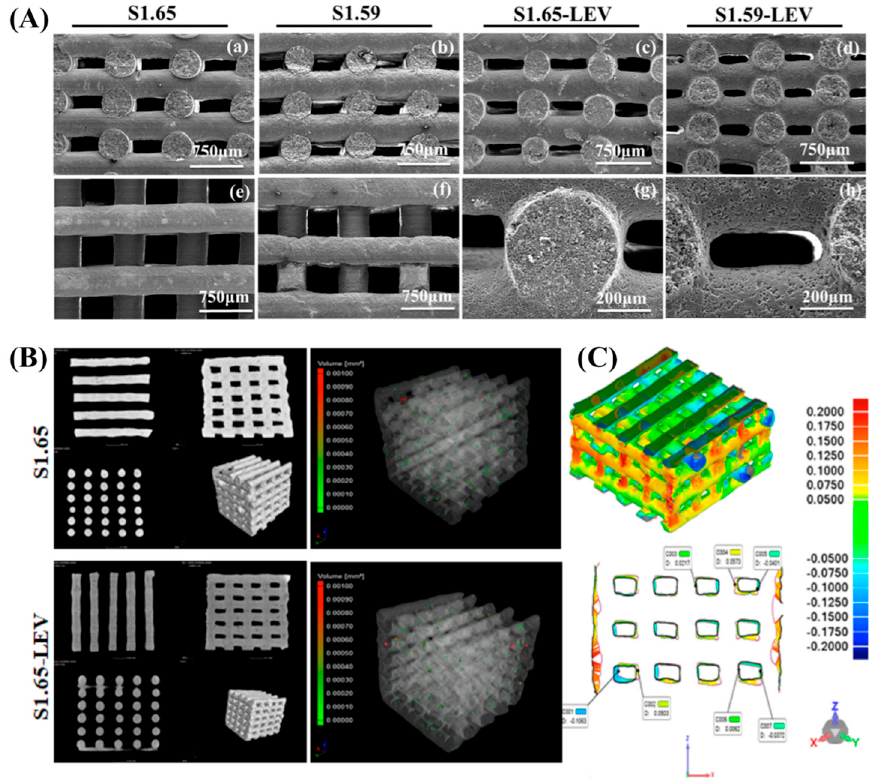
Figure 5. ( A ) Scanning electron micrographs showing morphological aspects of S1.65 (Ca/P = 1.65) and S1.59 (Ca/P = 1.59) scaffolds with and without levofloxacin: ( a – d ) lateral views; ( e , f ) top-views; ( g ) filament detail, ( h ) pore detail; ( B ) 2D (top plane and cross-section views) and 3D images of S1.65 scaffolds with and without drug (levofloxacin) obtained through Metrology CT and 3D reconstruction of the scaffolds mapped with color-coded for the internal porosity of filaments. ( C ) The 3D and 2D views of overlapped S1.65 and S1.65- levofloxacin (LEV) mapped with color-coding. Adapted from a previous study [119] with permission.